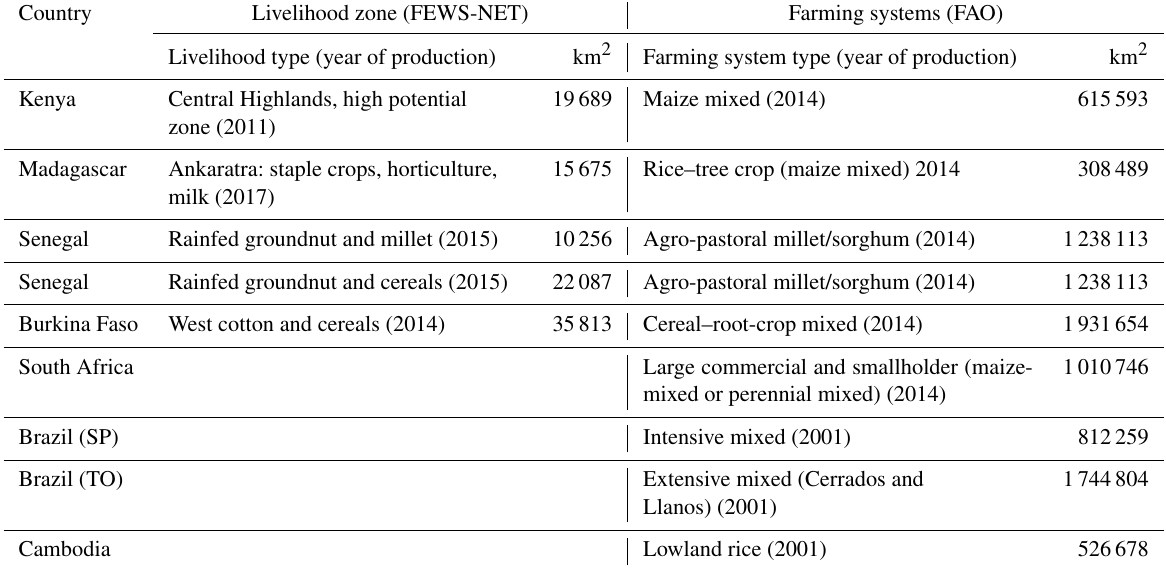
Table 3. Agricultural types and extent of study site zones: FEWS-NET livelihood zones (source: https://fews.net/fews-data/335, last access: 15 December 2021) and FAO farming system zones (http://www.fao.org/farmingsystems/mapstheme_01_en.htm, last access: 15 December